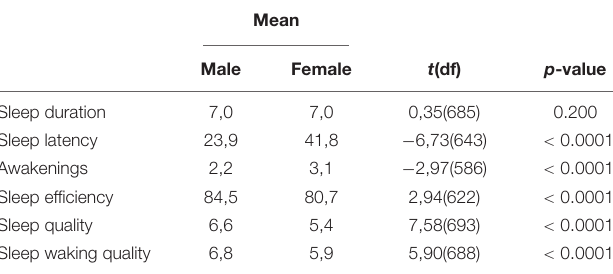
Mean Before During t (df) p -value COVID COVID